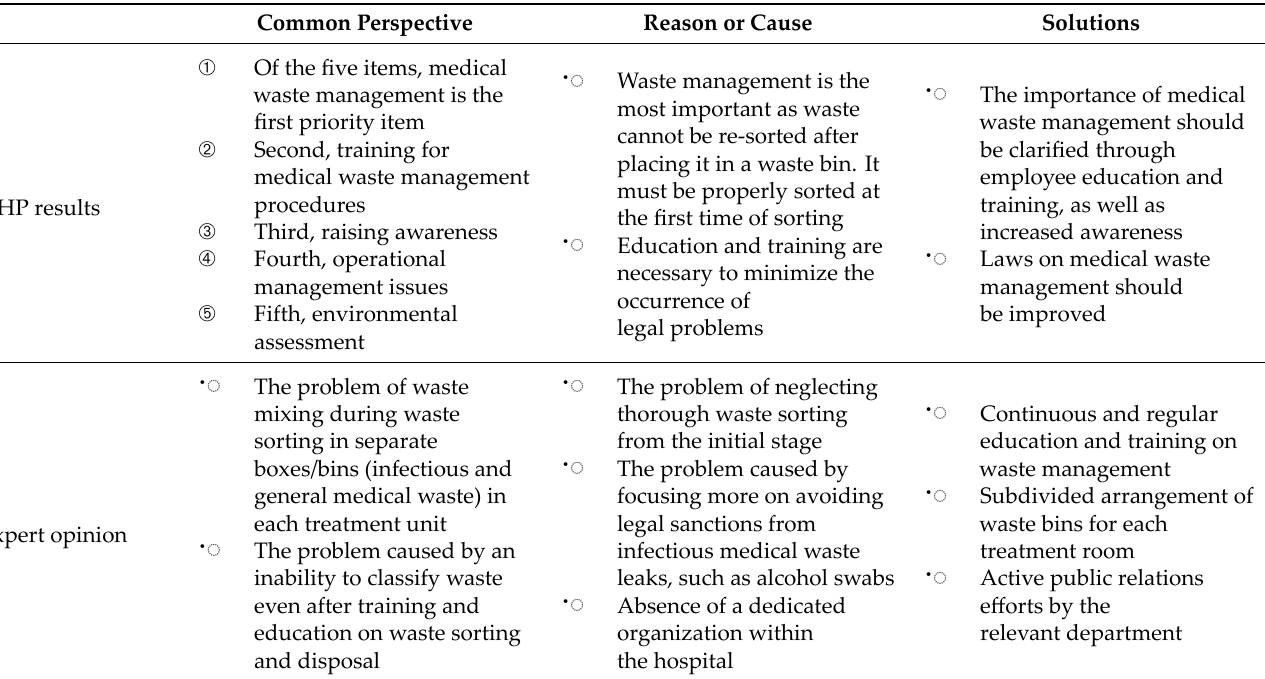
Table 6. Expert opinions on the analytic hierarchy process (AHP) results.